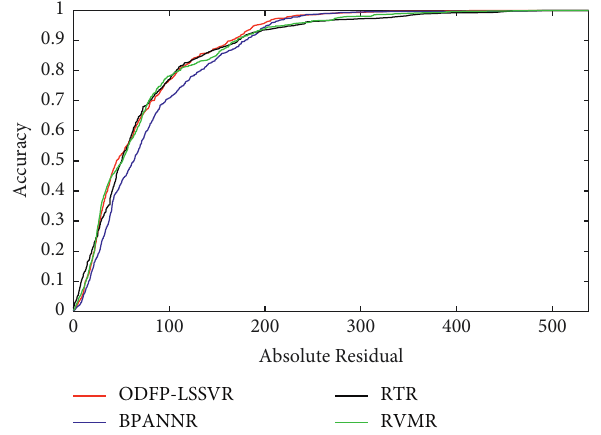
Figure 12: Regression error characteristic curves.